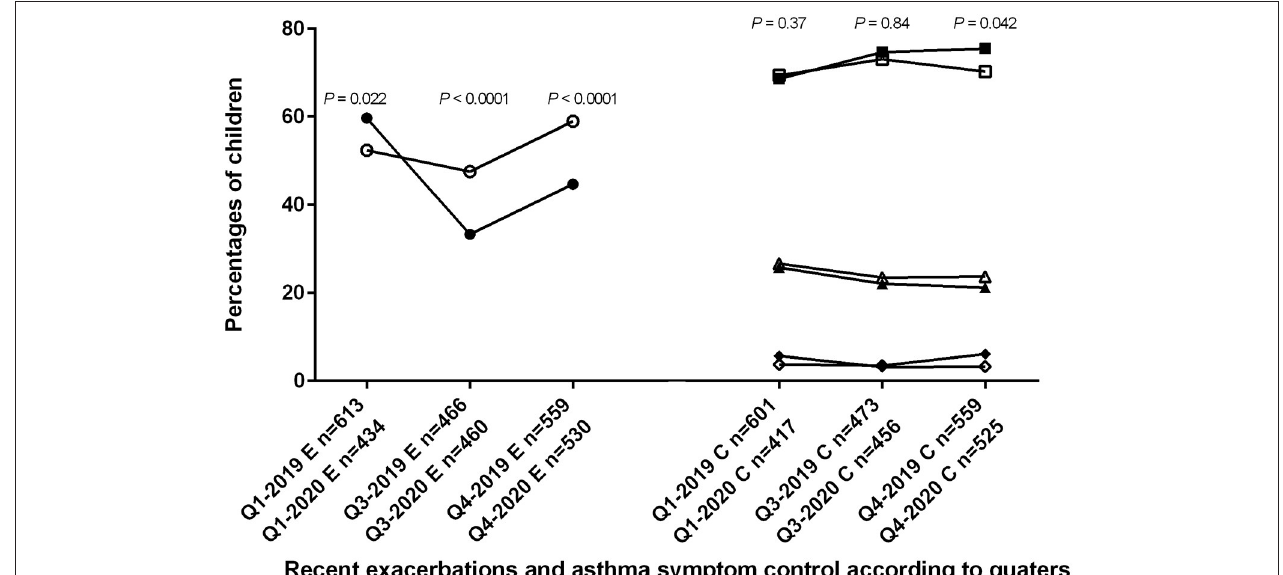
FIGURE 1 | Trends in 2019 and 2020 for asthma exacerbations in 3,166 children, and for asthma symptom control in 3,062 children. Q1-2019, Q3-2019, Q4-2019, Q1-2020, Q3-2020, and Q4-2020: first, third and fourth quarters of 2019 and 2020, respectively; E: results concerning the proportion of children with exacerbations; C: results concerning the proportion of children with different level of asthma symptom control. Open symbols represent the year 2019 and closed symbols the year 2020. Circles are percentages of children with exacerbations. Percentage was significantly higher during Q1-2020 compared to Q1-2019, and significantly lower during Q3-2020 and Q4-2020 compared to Q3-2019 and Q4-2019, respectively. Squares are percentages of children with controlled asthma symptom; triangles are percentages of children with partially controlled asthma symptom; diamonds are percentages of children with uncontrolled asthma symptom. Control of asthma was significantly better only during Q4-2020 compared to